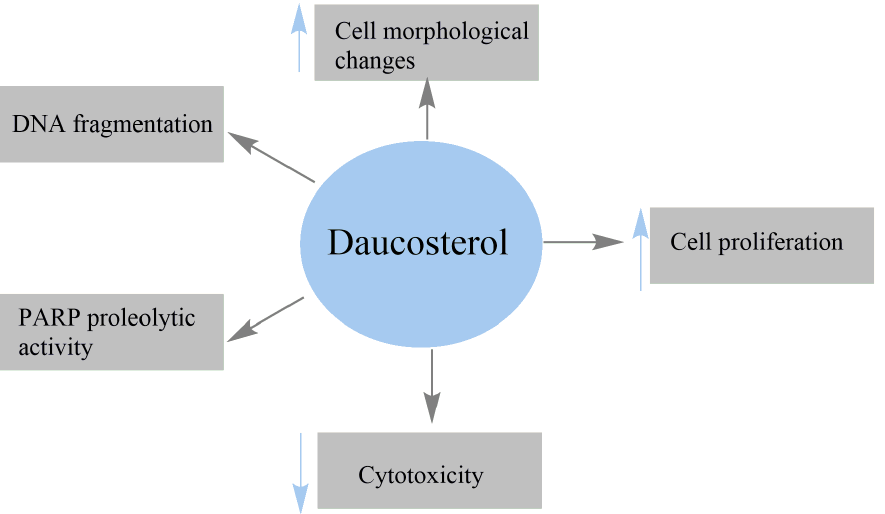
Figure 2. Anticancer mechanisms of Daucosterol. The arrow indicates increasing or decreasing.